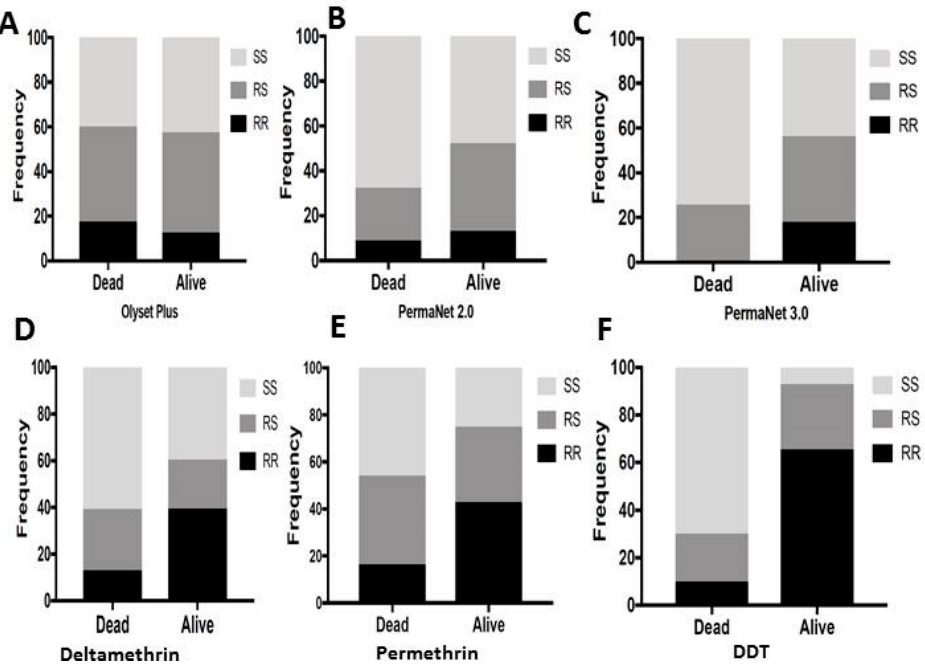
Figure 5. Association between L119F- GSTe2 mutation and ability to survive exposure to LLINs (cone assays) and WHO papers (bioassays): ( A ) Genotype distribution of L119F -GSTe2 between alive and dead mosquitoes after exposure to Olyset Plus showing no association; ( B ) Genotype distribution of L119F- GSTe2 between alive and dead mosquitoes after exposure to PermaNet 2.0 showing